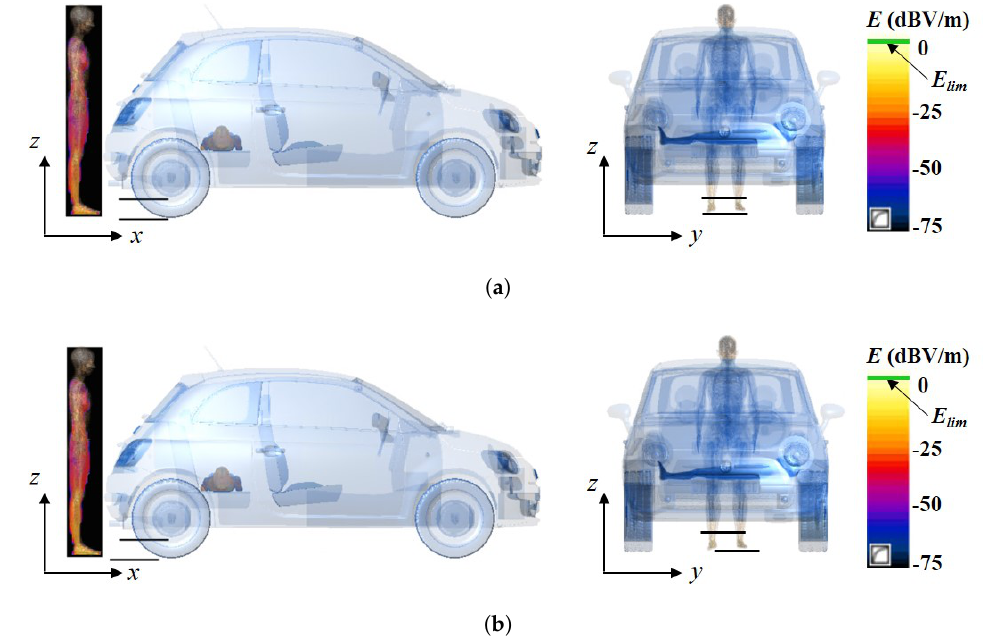
Figure 7. E -field distributions for exposure scenario #3 in the aligned ( a ) and misaligned ( b ) coil positions. E lim is the BR = 11.48 V/m (the green area is the portion where the BR is